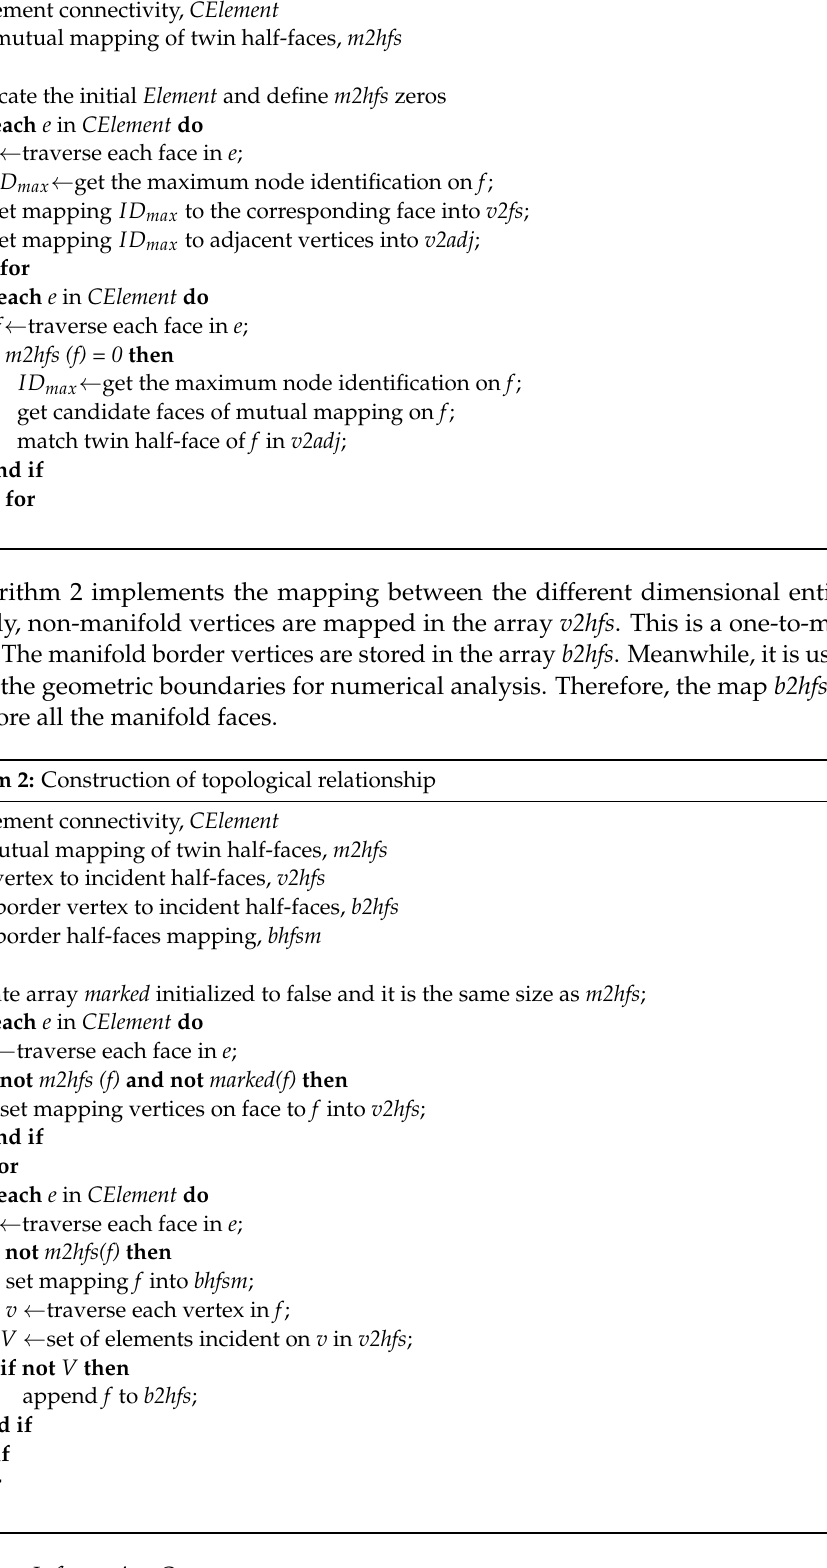
Algorithm 1: Construction of twin half-faces